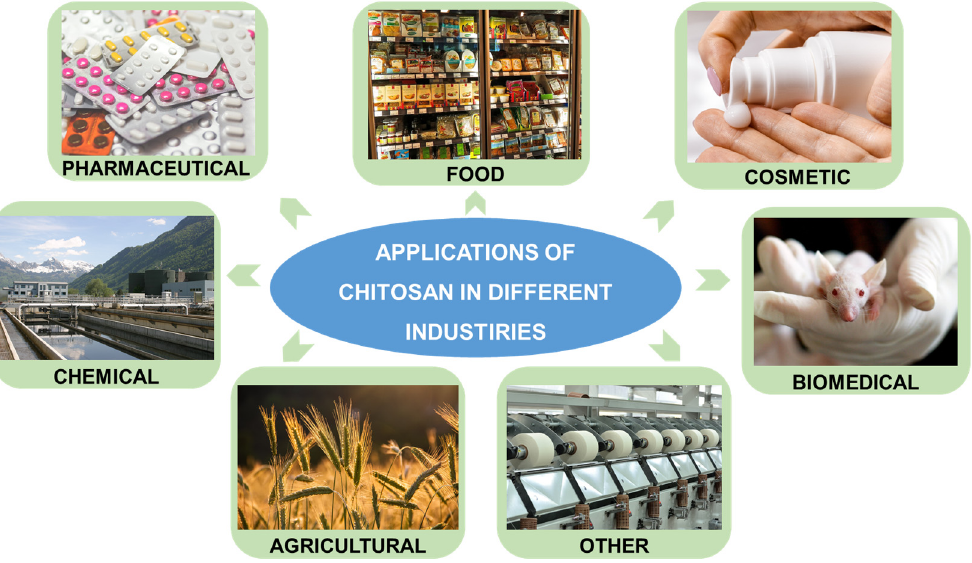
Figure 2. A schematic representation of diverse applications of chitosan-based materials.